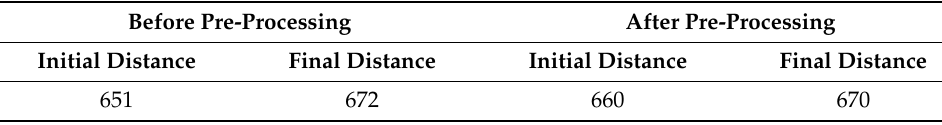
Table 2. An example of a pre-processing